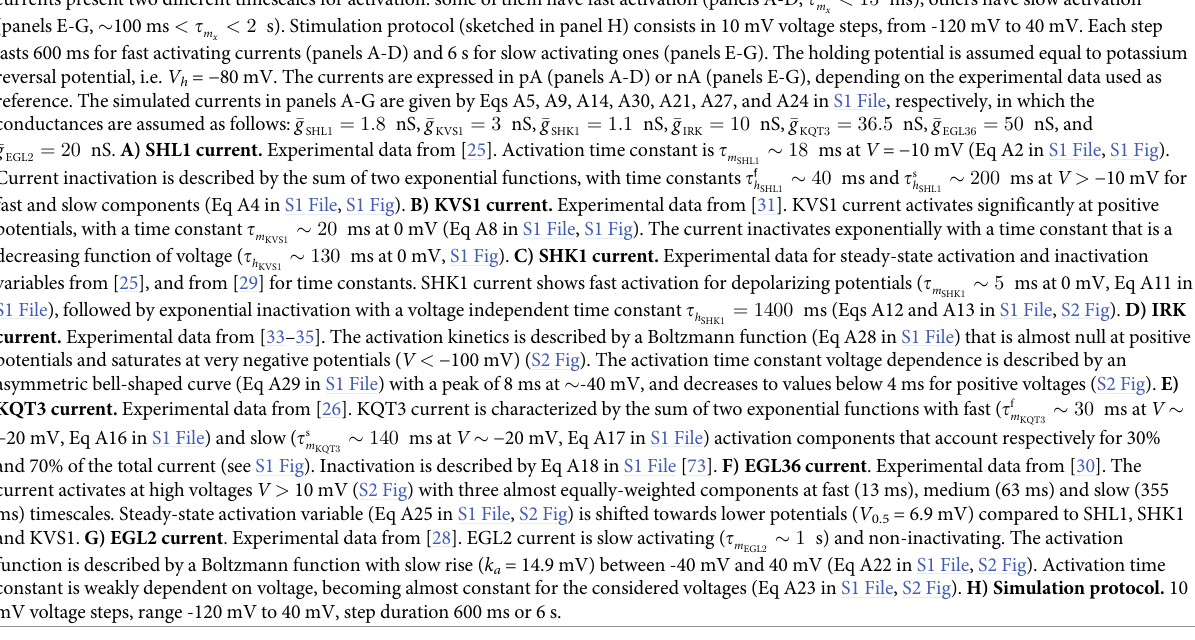
< 15 ms ), others have slow activation m x